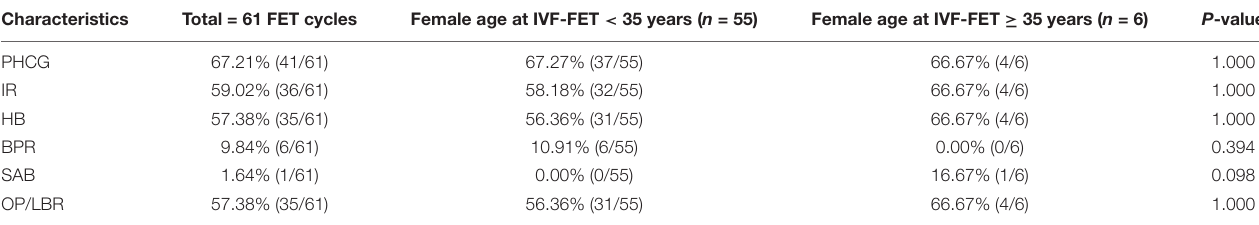
TABLE 3 | Pregnancy outcomes in 43 couples with high risk of genetic kidney disease.